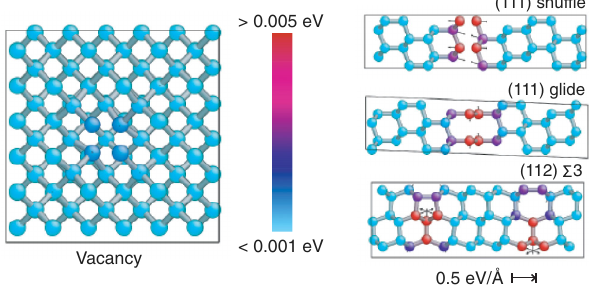
FIG. 2. Visualization of vacancy, (111) shuffle and glide unstable stacking faults, and ð 112 Þ Σ 3 grain boundary configu- rations. Atoms are colored by the per-atom energy errors predicted by the GAP on the DFT-relaxed configurations, and arrows show the nonzero GAP